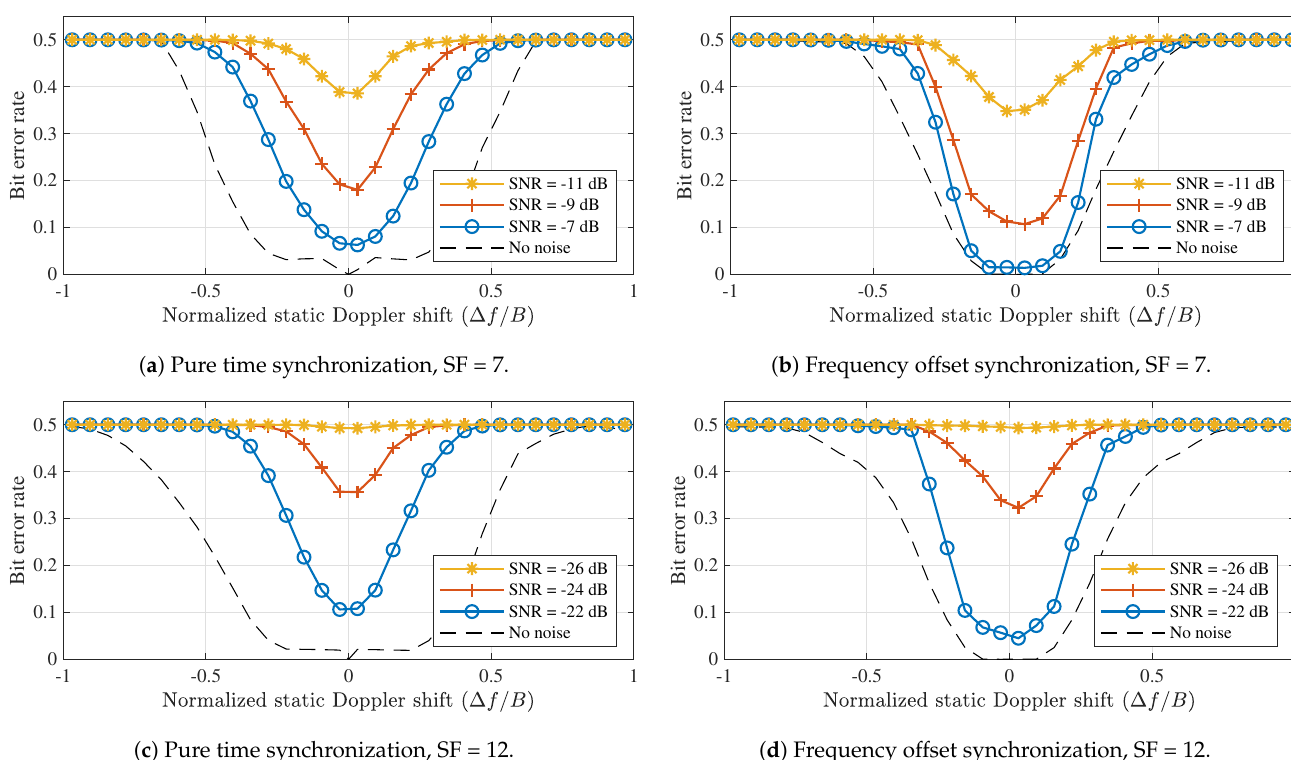
Figure 6. Bit error performance when using the different synchronization strategies illustrated in Figure 4 for different spreading factors. Based on synthesized LoRa packets with 100 data symbols, received by simulated LoRa receivers. ( B =